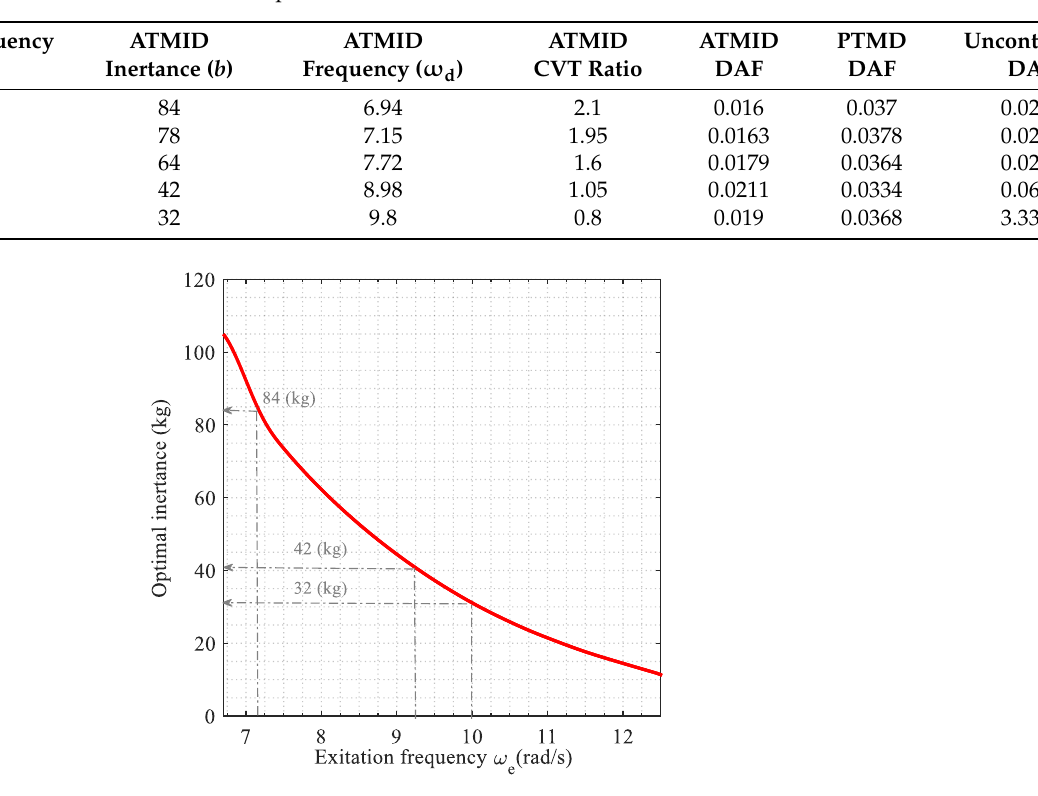
Figure 7. The FRC of the adaptive-controlled, passive-controlled, and uncontrolled SDOF structures. Table 3. Comparison of the uncontrolled, PTMD-controlled, and ATMID-controlled methods.